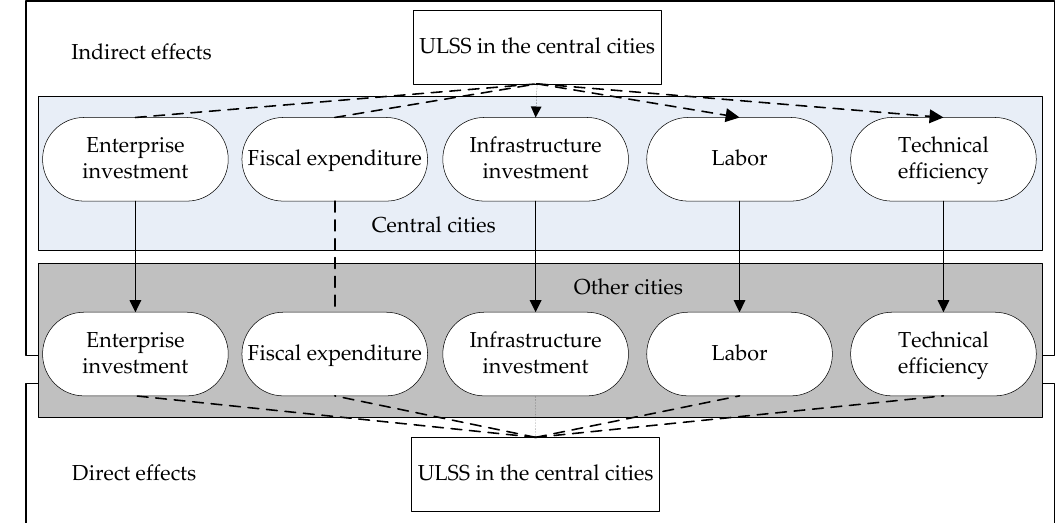
Figure 6. The impacts of ULSS on the production factors in urban agglomerations.